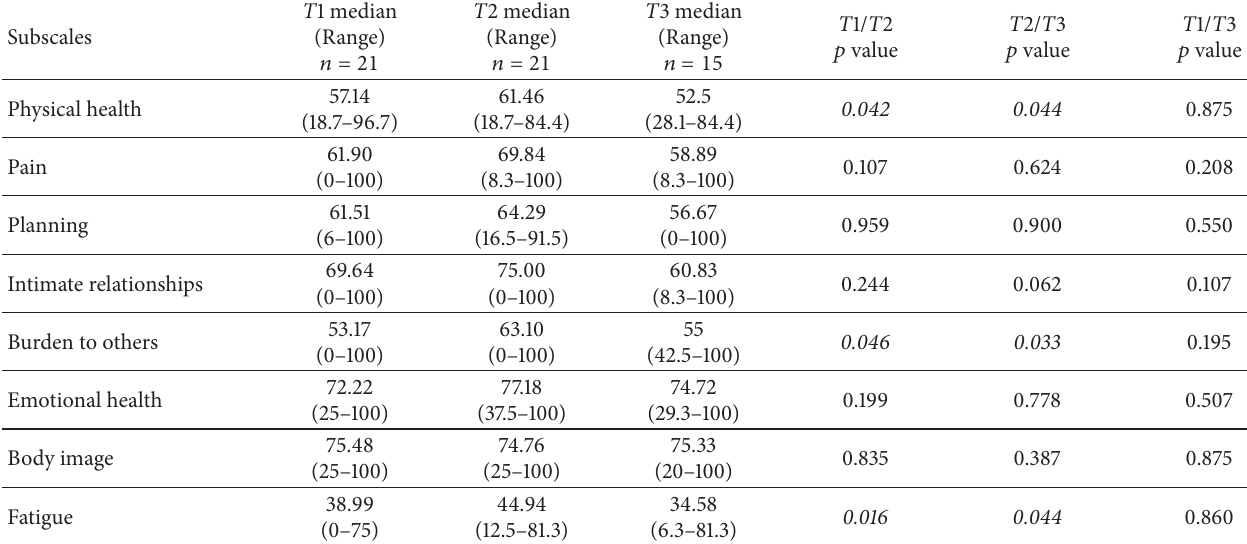
Table 3: LupusQol T 1, T 2, and T 3